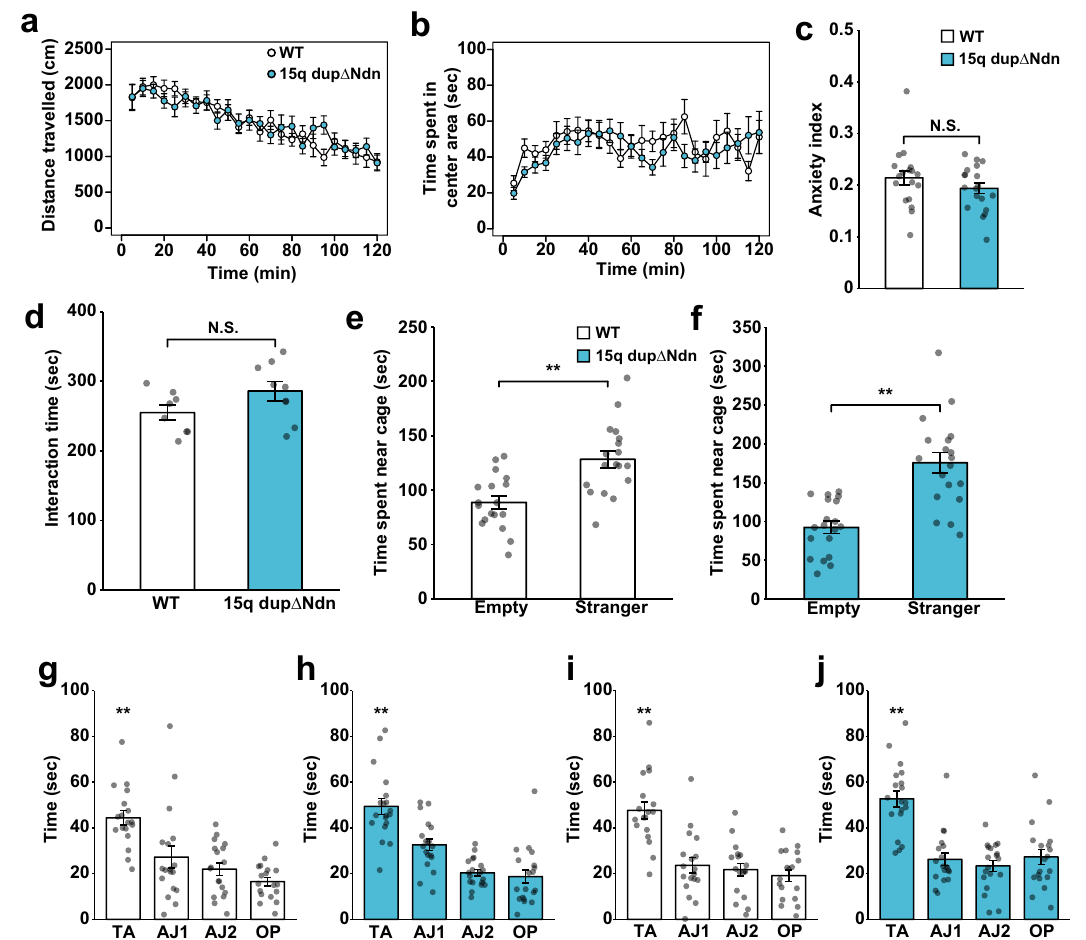
Fig. 6 Paternal 15q dup Δ Ndn mice are recovered from abnormal behaviors found in paternal 15q dup mice. a – c Open fi eld test. a total distance traveled, b time spent in the center area, and c anxiety index. N = 18, 19 biologically independent mice for WT and 15q dup Δ Ndn mice. d Reciprocal social interaction test. The time spent in social interaction for each pair of mice is shown. N = 8 and 9 pairs for WT and 15q dup Δ Ndn mice, respectively. e , f Three- chambered social interaction test. (Left) WT N = 18, (Right) 15q dup Δ Ndn N = 19 biologically independent mice. WT: Empty vs. Stranger: p = 0.0004, 15q dup Δ Ndn : Empty vs. Stranger: p = 0.0002. ** p < 0.01 (paired t -test). g , h Results of the probe test after spatial learning training in the Barnes maze test. WT: TA vs. AJ1: p = 0.0013, TA vs. AJ2/OP: p < 0.0001, 15q dup Δ Ndn : TA vs. AJ1/AJ2/OP: p < 0.0001. ** p < 0.01 (Dunnett ’ s test). i , j Results of the reversal probe test. N = 18 for WT, 19 for 15q dup Δ Ndn biologically independent mice. WT: TA vs. AJ1/AJ2/OP: p < 0.0001, 15q dup Δ Ndn : TA vs.